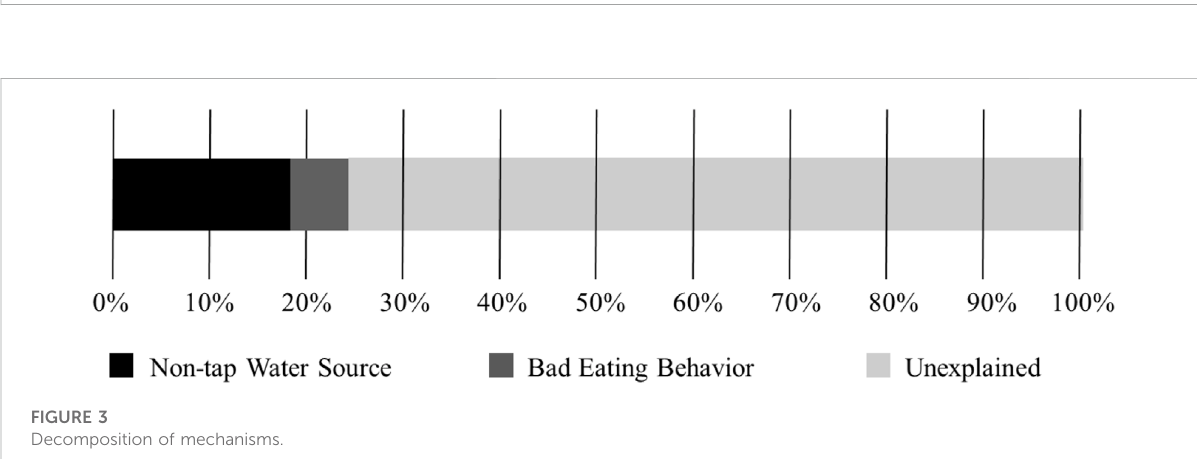
FIGURE 3 Decomposition of